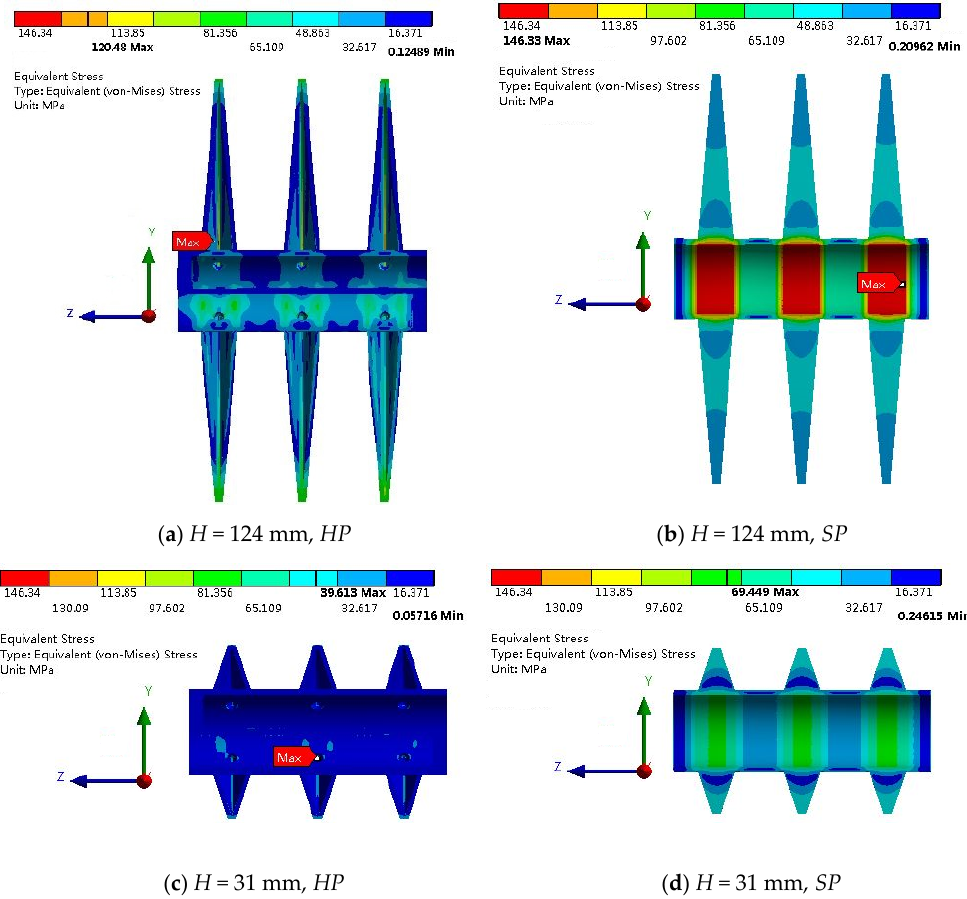
Figure 6. Stress distribution for two paddle heights: h o = 250 W/(m 2 K), m  = 1 kg/s, Δ T = 100 °C, d = 8 mm, t = 3 mm, m = 2. d = 8 mm, t = 3 mm, m = 2.